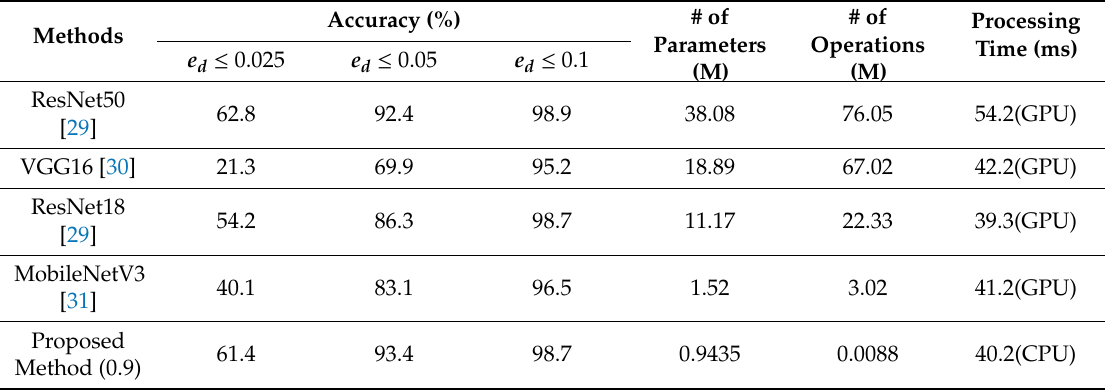
Table 7. Comparison of accuracy, processing time, and numbers of parameters and operations with CNN-based models using BioID dataset. The proposed method removes 10% of the rules through a rule distillation from the original CCD-RF